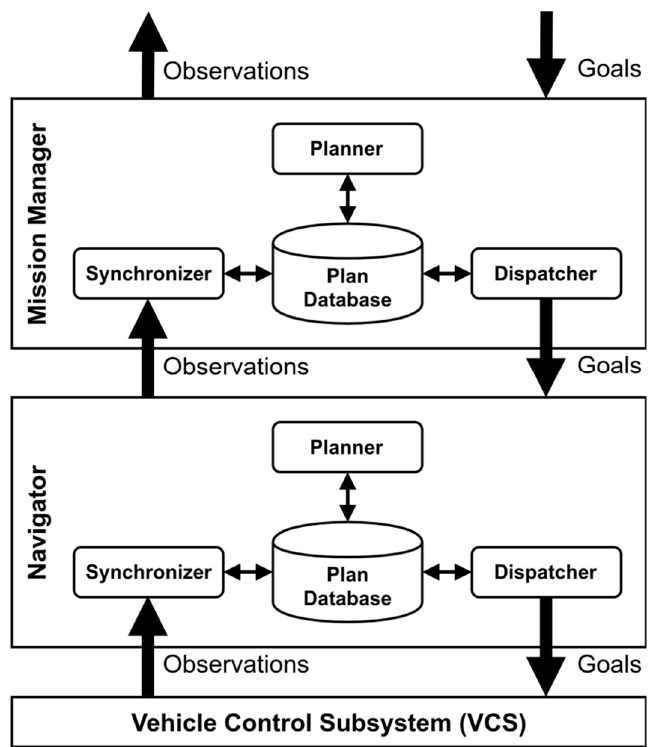
Figure 10. An example of the design of a T-REX integrated system.